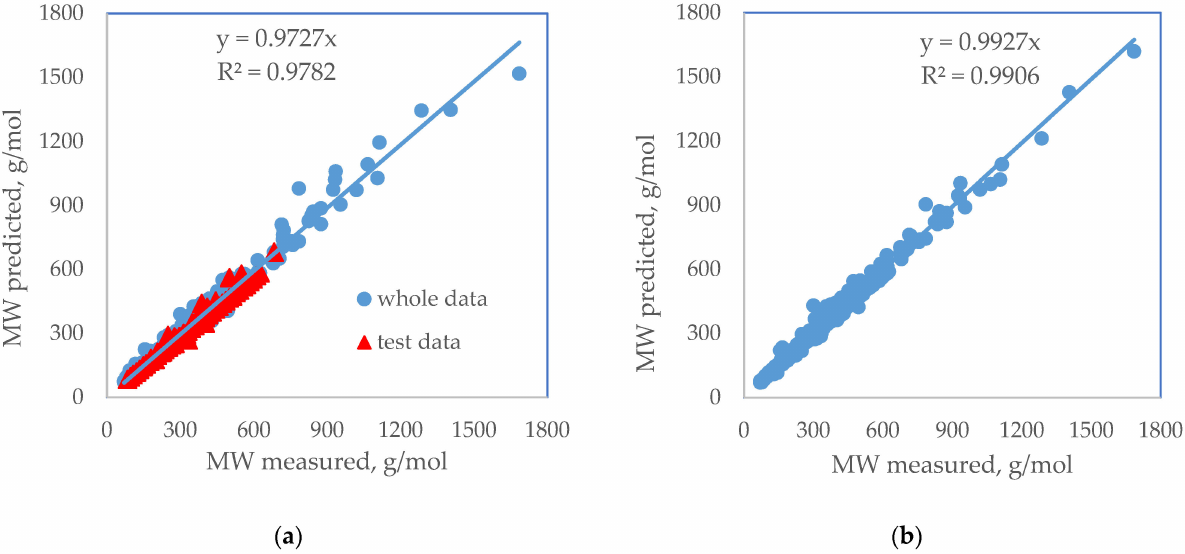
Figure 5. Parity graph for predicted versus measured molecular weight by Equation (20) ( a ) and by the ANN model ( b ).